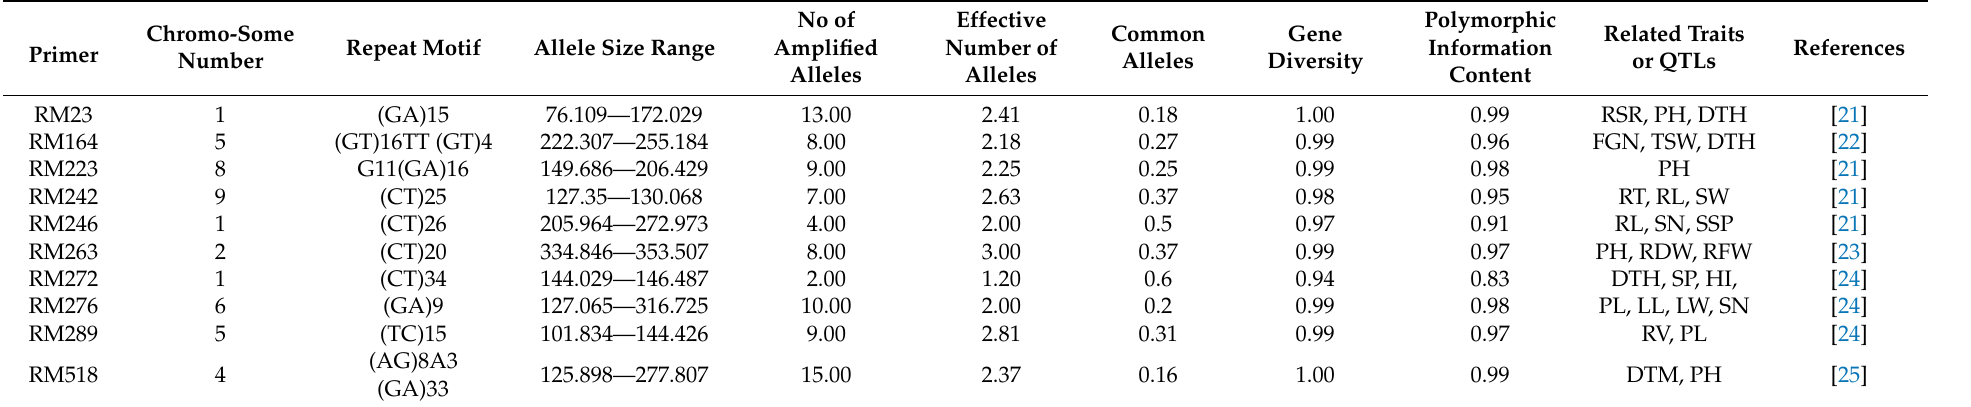
Table 3. Genetic details of SSR markers were used in the